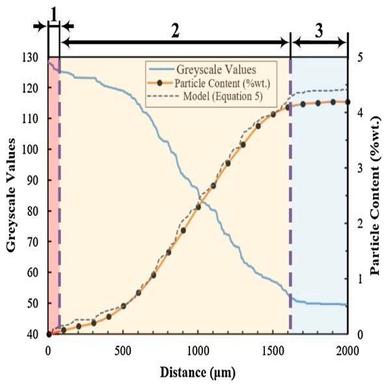
Comparison between the greyscale values (blue curve), particle weight fraction (red curve) extracted from nano-CT data, and particle weight fraction extracted from the correlation between greyscale values and particle content for the sample with 0.3-mm thickness (For interpretation of the references to colour in this figure legend, the reader is referred to the web version of this article.).